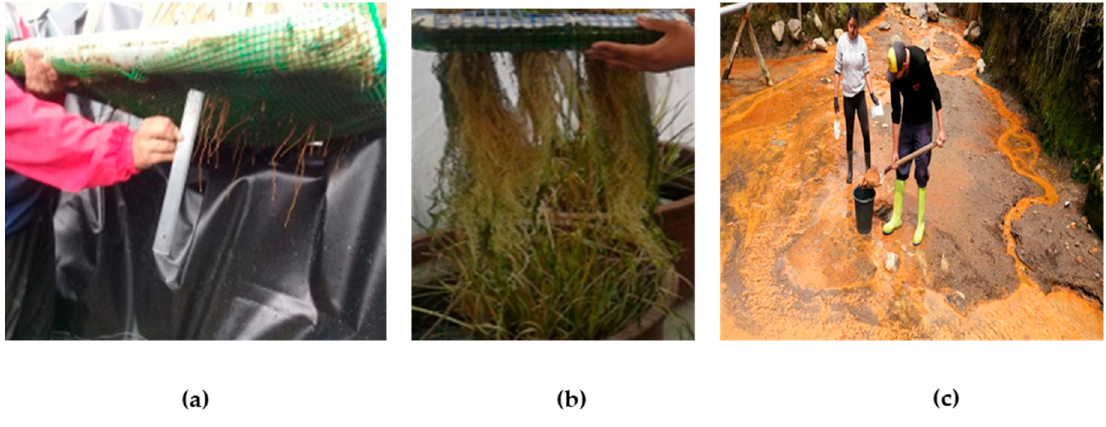
Figure 4. Root system length at ( a ) the beginning and ( b ) elapsed 120 days of the treatment. ( c ) observed natural high As concentration.